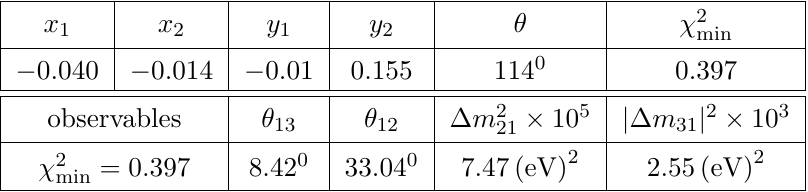
Table 3 . Parameters and observables corresponding (cid:31) 2 = 0 : 397 for normal mass